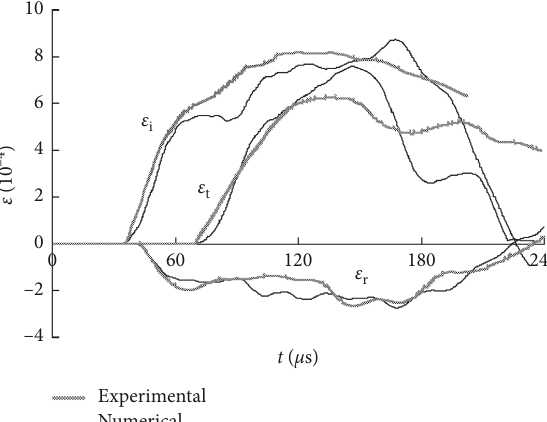
Figure 4: The incident strain ε to the experimental curves